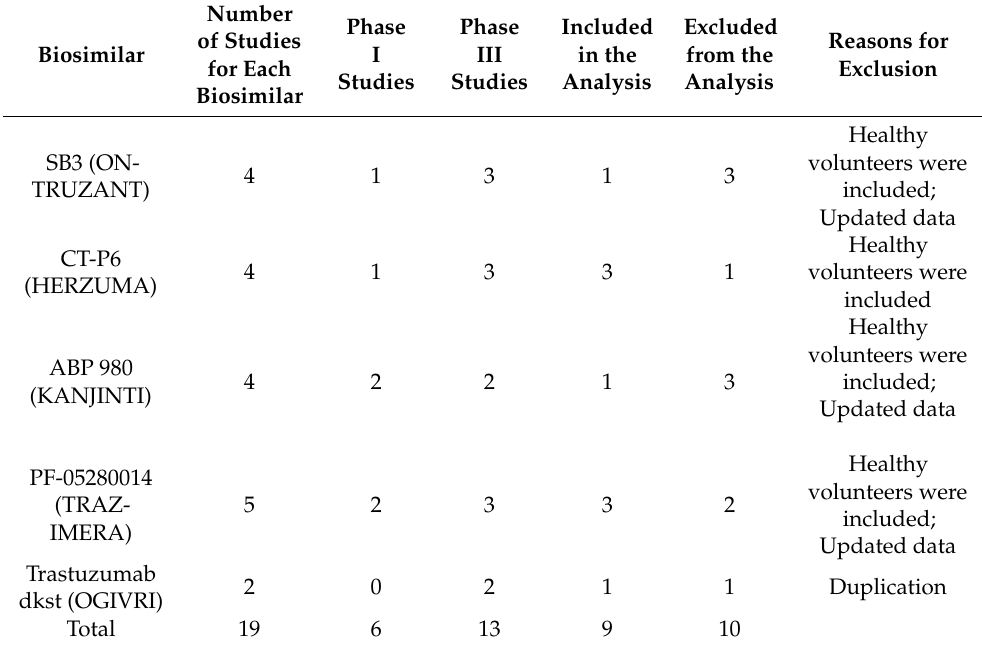
Table 4. Number of studies excluded with reasons for approved trastuzumab